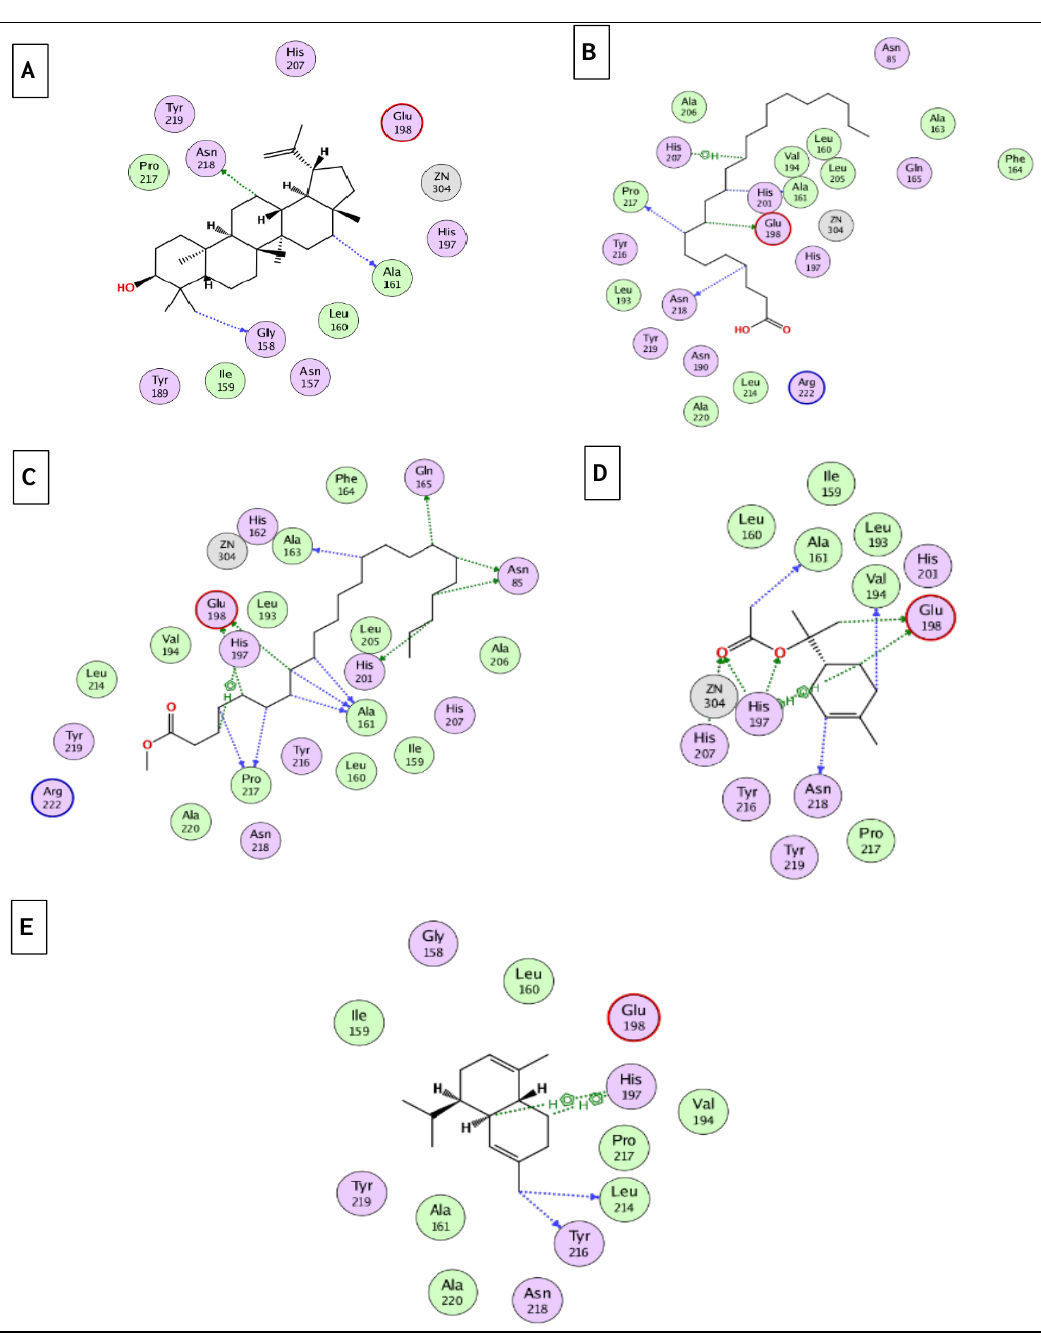
Figure 8. 2D binding modes of lupeol ( A ), n- docosanoic acid ( B ), methyl tricosanoate ( C ), α -terpinyl acetate ( D ), and α -muurolene ( E ) to the active binding sites of matrix metalloproteinases-8 (MMP-8).